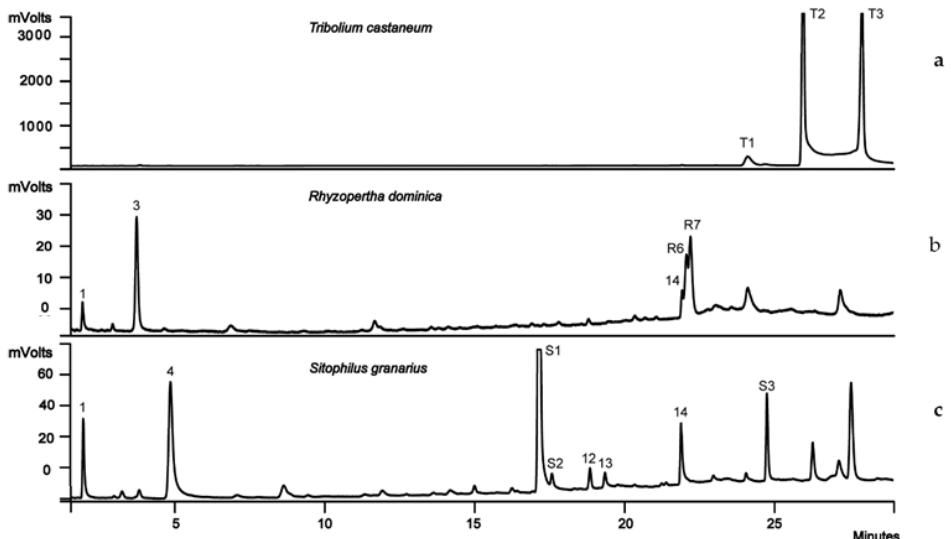
Figure 3. GC chromatograms of headspace volatiles from ( a ) Tribolium castaneum , ( b ) Rhyzopertha dominica , and ( c ) Sitophilis granarius . Peaks T1, T2, T3 are benzoquinones; peak 1 = Acetone; peak 3 = Ethanol; peak 4 = 2,3-Butanedione; peak 12 = 3-Methyl-2-buten-1-ol; peak 13 = 1-Hexanol; peak 14 = 1-Pentadecene; peak R6 = Dominicalure 2; peak R7 = Dominicalure 1; peaks S1–3 = typical peaks of S. granarius only; and peak S1 = 3-Hydroxy-2-butanone.